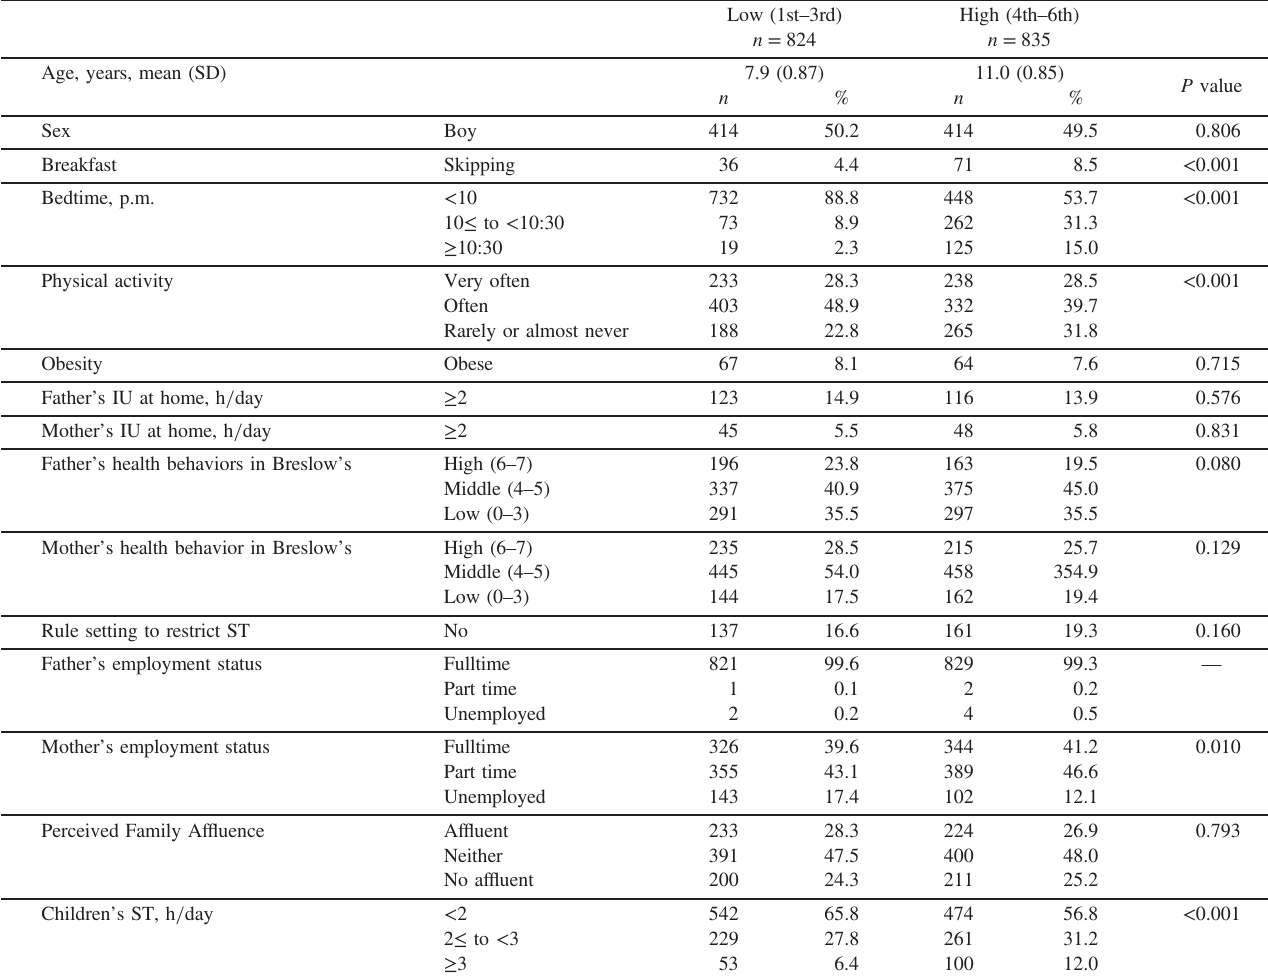
Table 1. Characteristics of children by grade ( n =